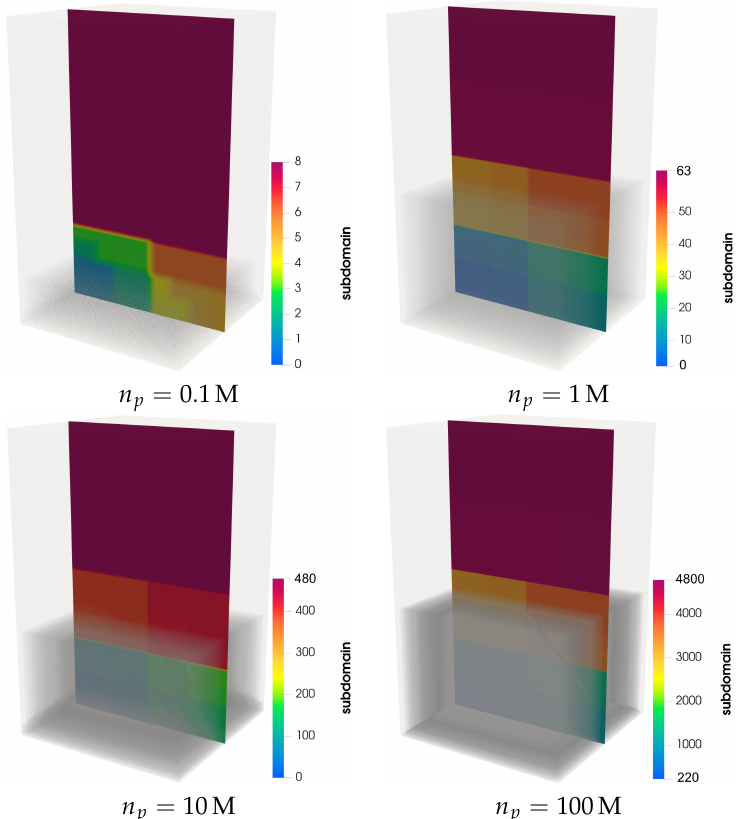
Figure 6. Simulation screenshots of packing of 0.1M, 1M, 10M, 100M particles on 8, 48, 480, and 4800 processes at t =